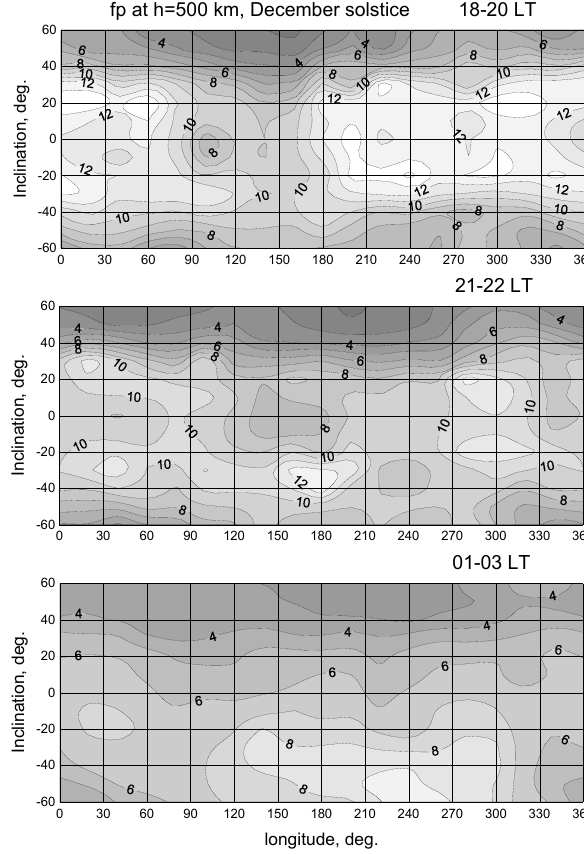
Fig. 3. The same as in Fig. 2 but for hm F2.